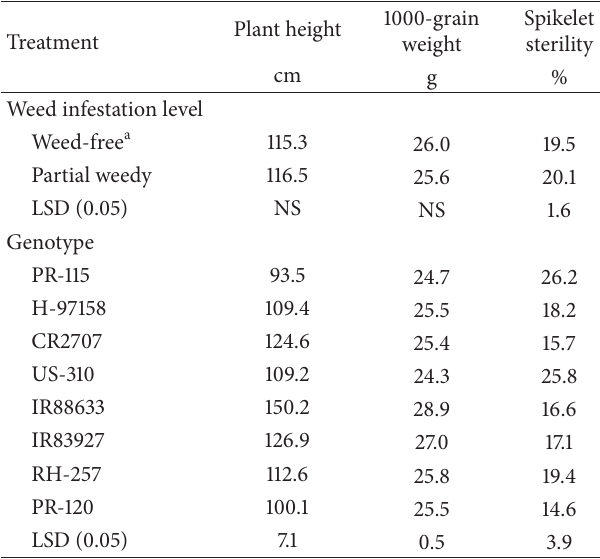
Table 6: Final plant height (cm plant −1 ), 1000-grain weight (g), and spikelet sterility (%) in response to weed infestation levels and genotypes.